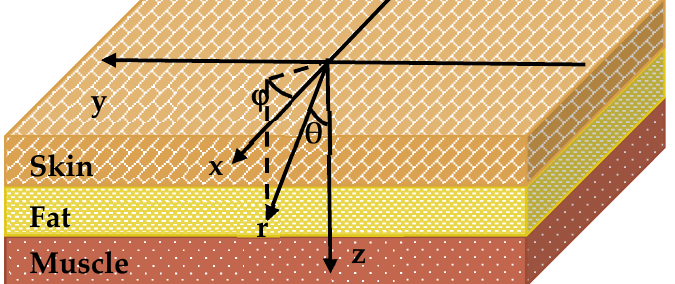
Figure 2. Layer model diagram of facial tissues with coordinate system used in Monte Carlo simulations.